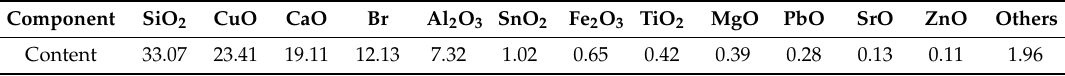
Table 1. ICP chemical analysis of waste printed circuit boards (WPCBs; wt